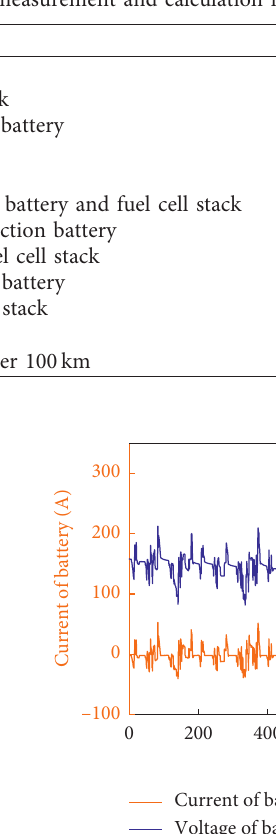
Table 2: The measurement and calculation results of H